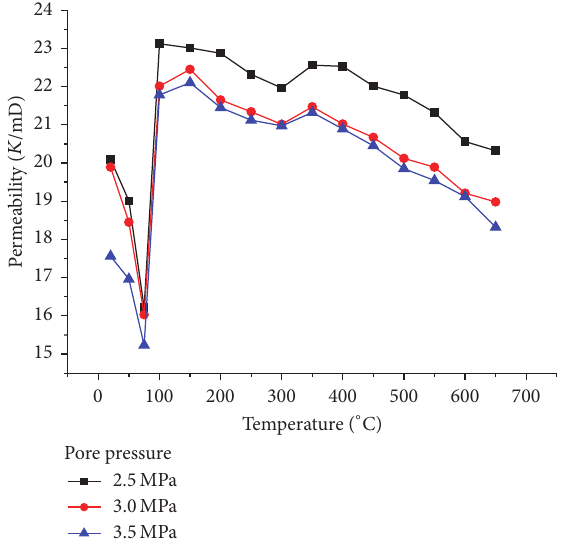
Figure 12: Variations of permeability with temperature with pore pressure ranging from 2.5 to 3.5 MPa (category II).